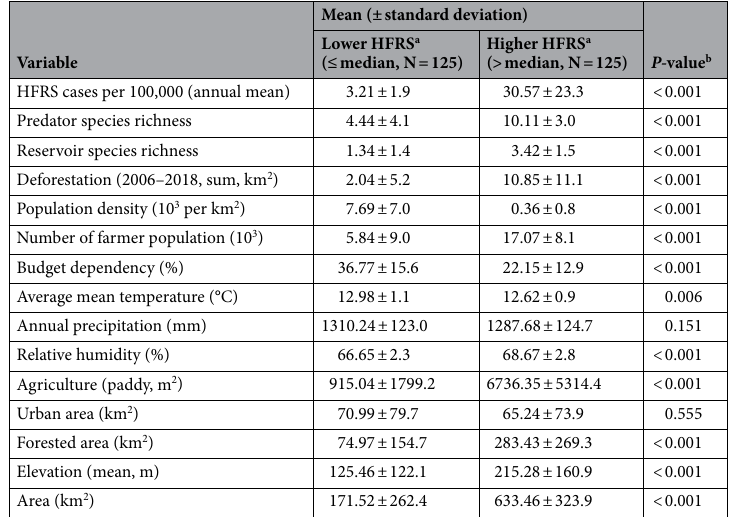
Table 1. Descriptive analysis of variables included in this study according to districts with higher versus lower HFRS values. The descriptive analyses were conducted using data for 13 years (2006–2018) for 250 districts in South Korea. a Annual cases of haemorrhagic fever with renal syndrome per 100,000 population in each district (median = 7.87). b P values from t